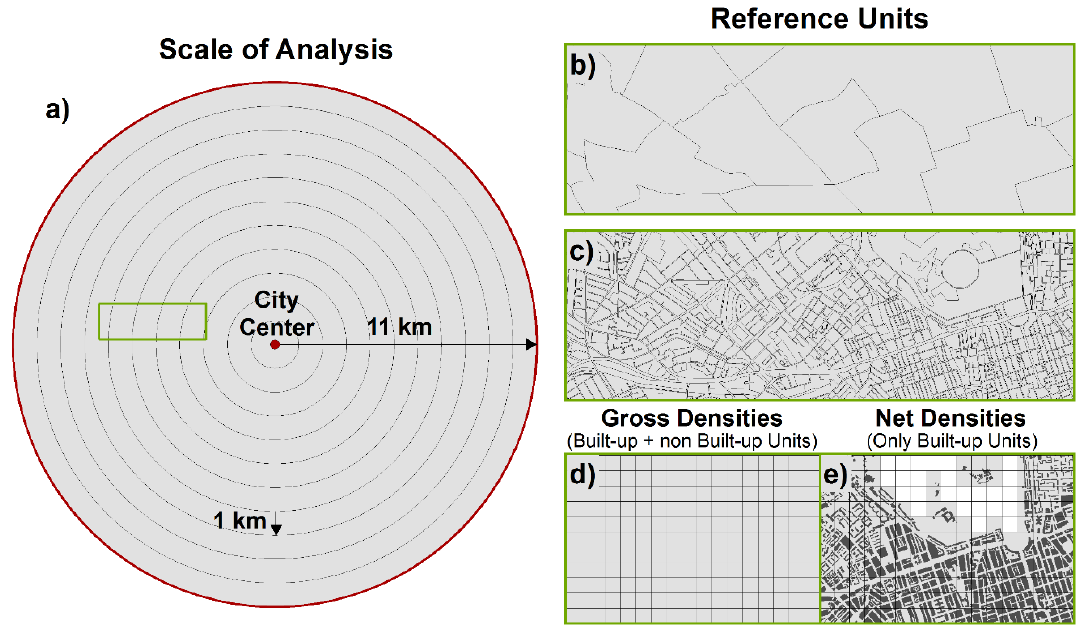
Figure 3. The spatial scales ( a ); and reference units ( b − d ) for measuring density for the city scale and the ring model. ( b − d ) Units of measurement with: ( b ) administrative units; ( c ) block units; and ( d ) grid units. ( e ) The differentiation between gross and net densities is visualized.